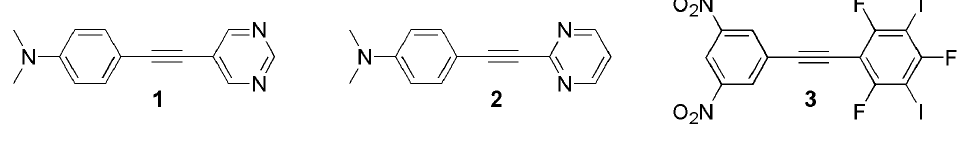
Figure 2. Compounds used in this study.